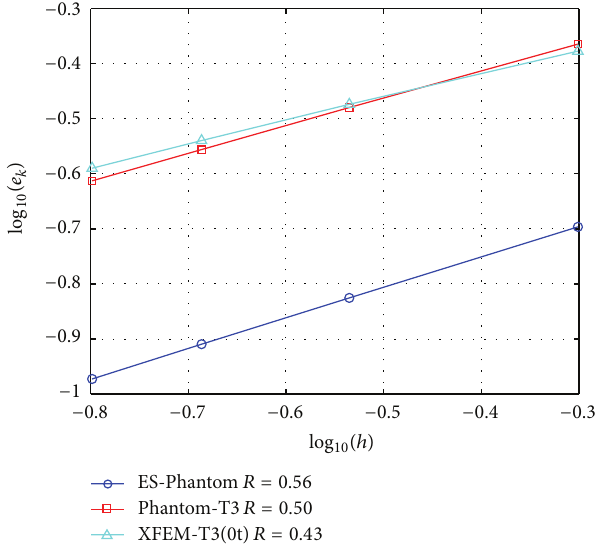
Figure 20: The convergence in the stress intensity factor 𝐾 𝐼 versus ℎ (mesh size) for a sheet with an edge crack under shear.